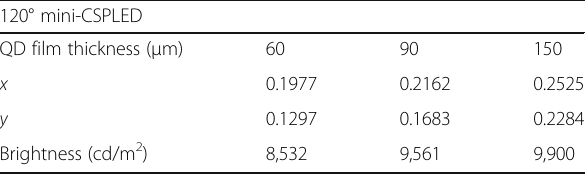
Table 3 The CIE chromaticity coordinates ( x , y ) and brightness for the 150° mini-CSPLEDs with different QD film